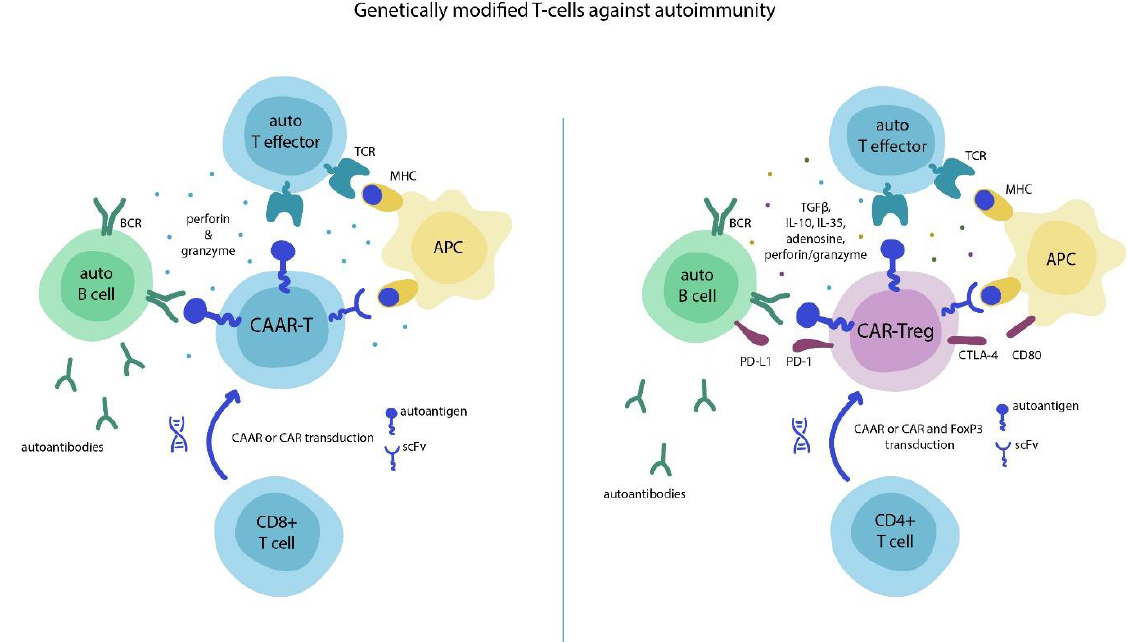
Figure 1. Mechanisms of chimeric autoantibody receptor (CAAR)-T and chimeric antigen receptor (CAR)-Treg activity. CAAR-Ts recognize autoreactive B and T cells with receptors to autoantigens, as well as autoreactive antigen-presenting cells (APCs), through an major histocompatibility complex (MHC):autoantigen complex. They then execute the cytotoxic perforin/granzyme-based immune attack. CAR-Tregs identify targets in the same manner, but their action can be considered as immunosuppressive rather than cytotoxic because it is associated with cytokines and immune checkpoint proteins. Abbreviations: APC—antigen-presenting cell; BCR—B cell receptor; CAAR—chimeric autoantibody receptor; CTLA-4—cytotoxic